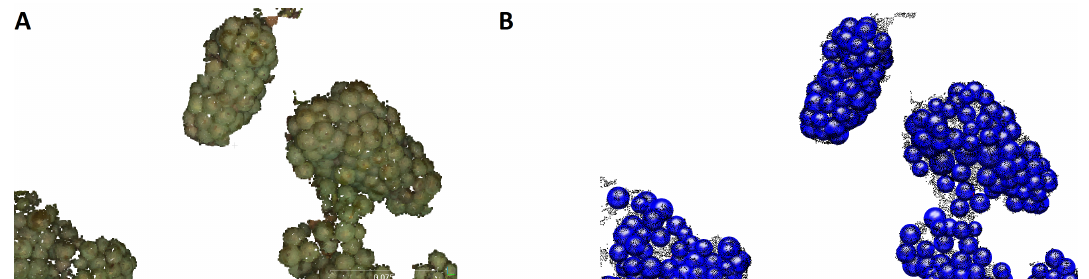
Figure 18. ( A ) Original points classified as grape bunch class; ( B ) Berries detected on several components. Almost all berries present in the point cloud are found, with some missing in areas where the spherical shape was not reconstructed properly.